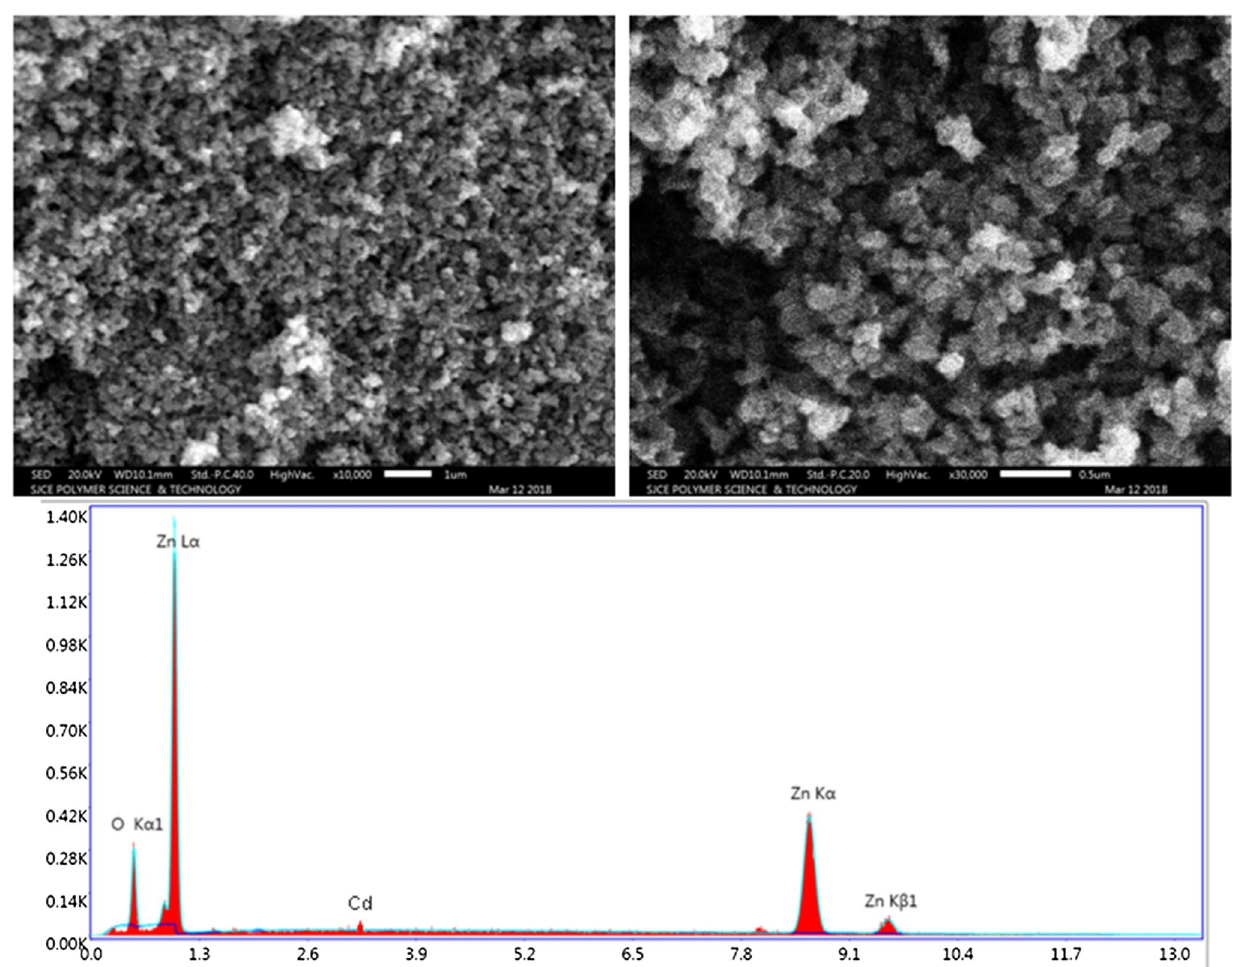
Fig. 4 Scanning electron microscopic images with energy-dispersive X-ray analysis of Cd/ZnO